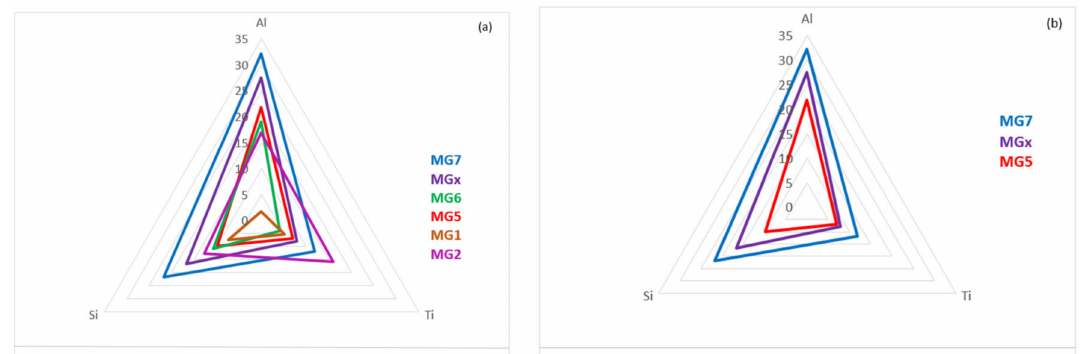
Figure 15. Macrosegregation map of Al, Si and Ti for the Nb-Ti-Si-Al-Hf system constructed using data for the alloys MG1, MG2, MG5, MG6, MG7 and MGx (see text). ( a ) All alloys, ( b ) alloys MG5, MGx,